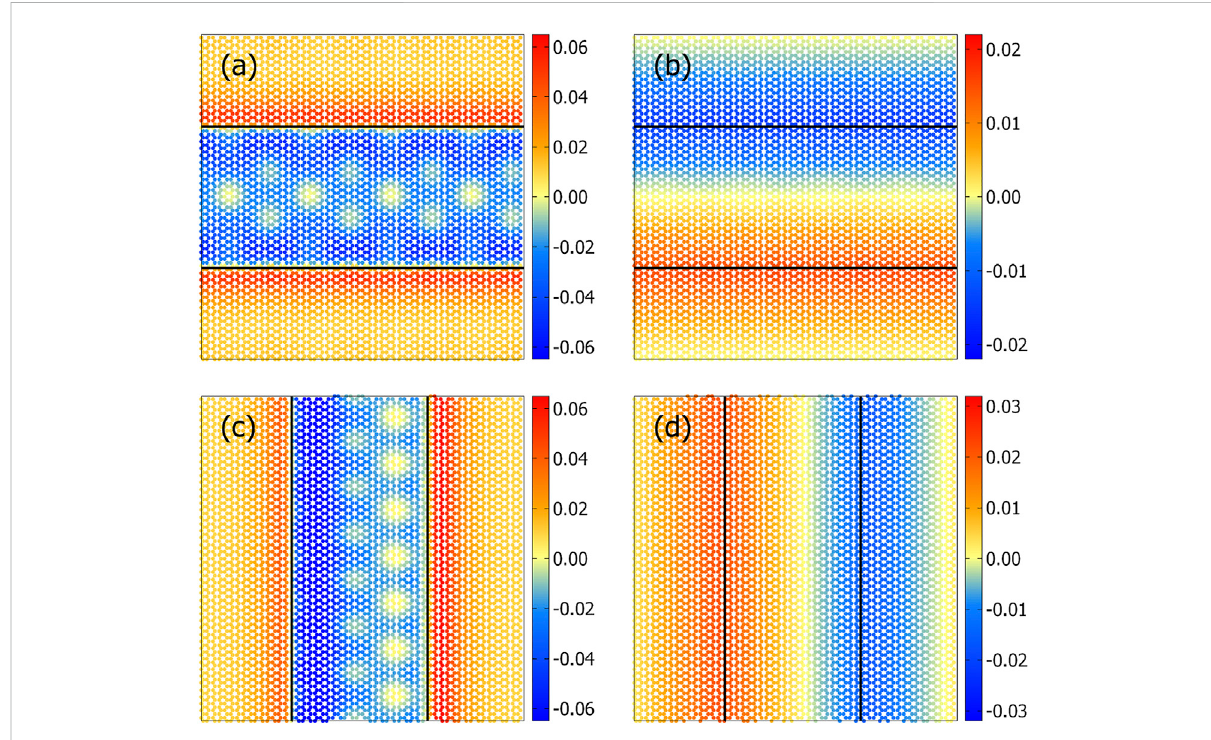
FIGURE 3 Static,atomicdisplacementinthetopmostgraphitelayerofan x -stripein (A) z -directionand (B) y -directionrelativetotheequilibriumpositions of a free-standing surface and similarly for a y -stripe in (C) z -direction and (D) x -direction. Displacements are given in Å.